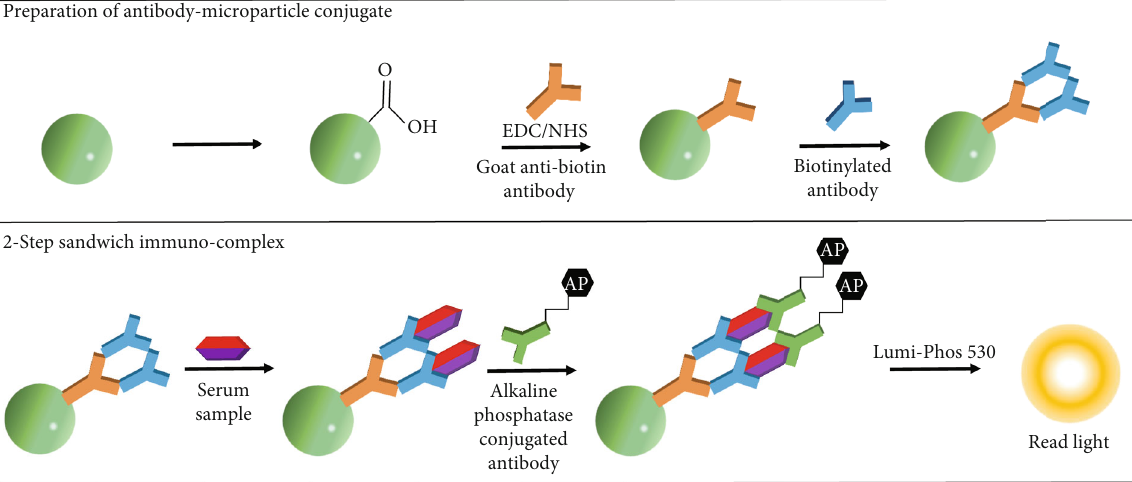
Figure 3: Magnetic antibody-microparticle conjugation. A strategy to prepare a universal magnetic microparticle that can be conjugated to any biotinylated capture antibody has been devised following the methodology set forth in Beckman Coulter literature.